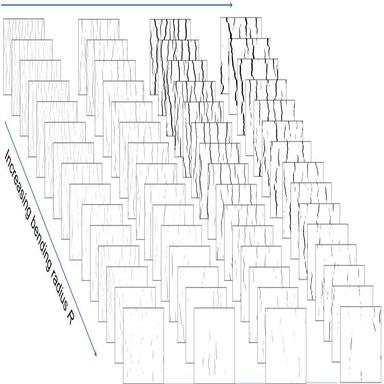
Post-processed SEM images showing crack evolution for different film thicknesses tf and local bending radii R. From left to right, tf=50, 75, 120, and 240 nm, respectively. The size of each image is 52 μm × 45 μm (width × height).